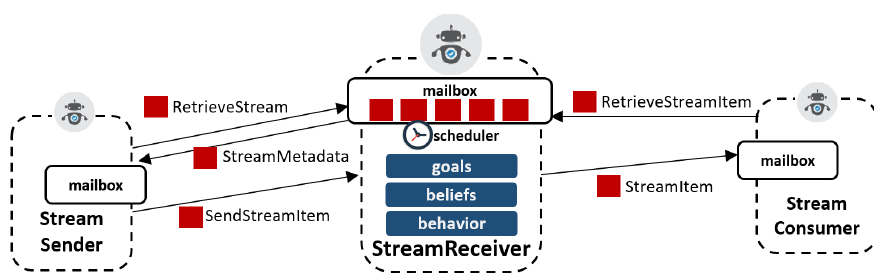
Figure 7. RSP Stream Receiver processes incoming messages from the sender that posts RDF stream items, and sends RDF stream items to a consumer. In case of real-time constraints, the scheduler will rely on a real-time compliant strategy to satisfy the established